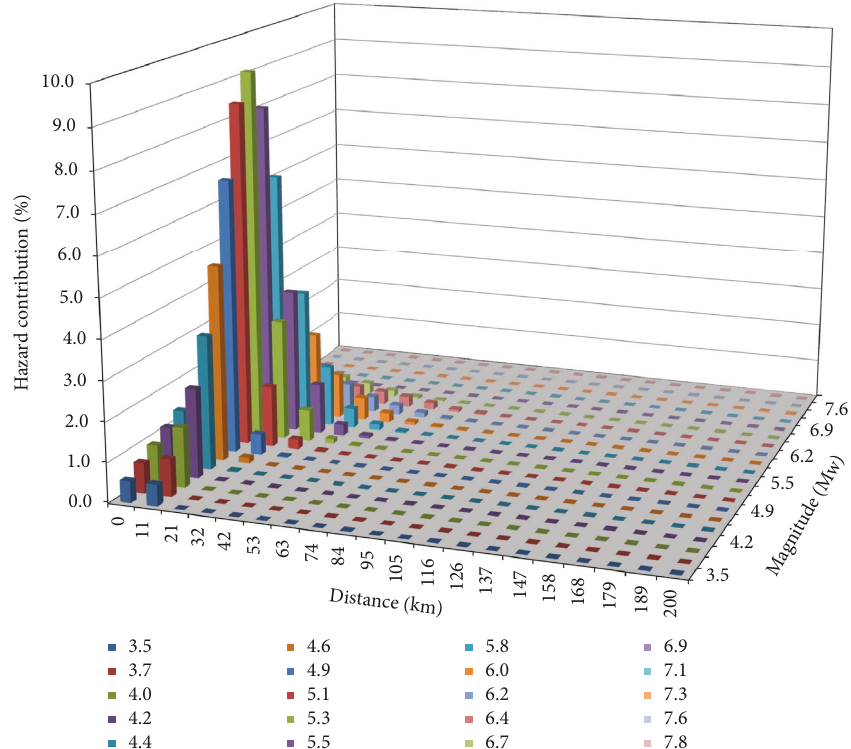
Figure 1: Deaggregation matrix for 4464years return period.